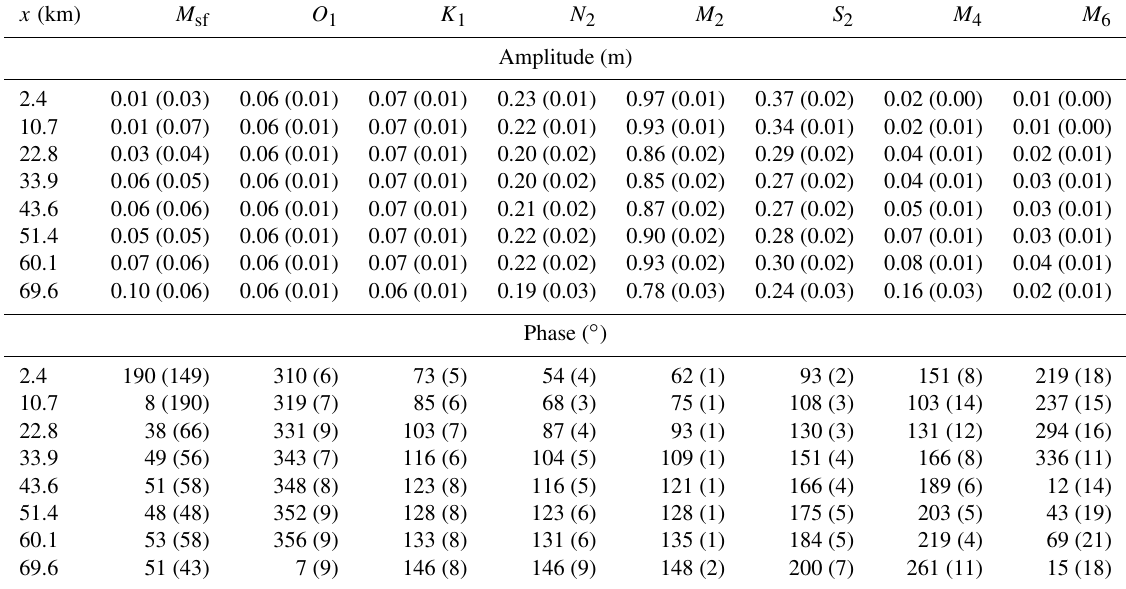
Table 2. Tidal elevation amplitudes (m) and phases ( ◦ ) estimates (with 95% confidence intervals in brackets) from harmonic analyses of pressure records along the Guadiana estuary ( x : distance from the mouth,